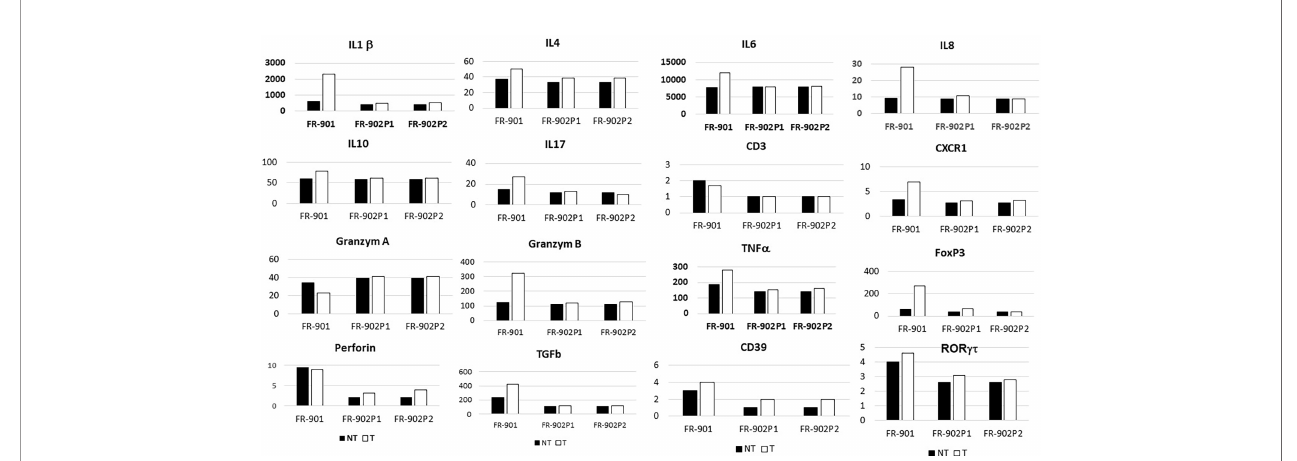
patient and her monozygotic sister, respectively; P1 and P2 are design polyps in the no-CRC patient.